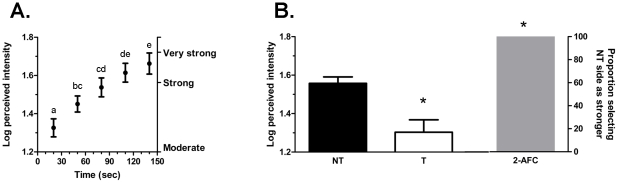
Temporal characteristics of tingle sensation evoked by repeated application of IBA.(A) Repeated application of IBA at 30-sec intervals evoked a tingle sensation that grew progressively in intensity. The intensity of the tingle sensation evoked by each application was greater than that evoked by preceding applications. Error bars indicate SEM and letters above bars indicate significant differences at p<0.05. (B) Panel shows a set of bar graphs. The left-hand pair plots the intensity ratings of tingle sensation for the non-treated (NT, black bar) and previously treated (T, open bar) side of the tongue, respectively. The gray bar to the right indicates the proportion of subjects choosing the non-treated side as yielding a stronger tingle sensation in the 2-AFC test. Error bars indicate SEM. * above open bar indicates significant difference (p<0.05) between pretreated and nontreated sides of the tongue. * above gray bar indicates significant majority (p<0.05) of subjects chose non-treated side as having stronger tingling sensation.